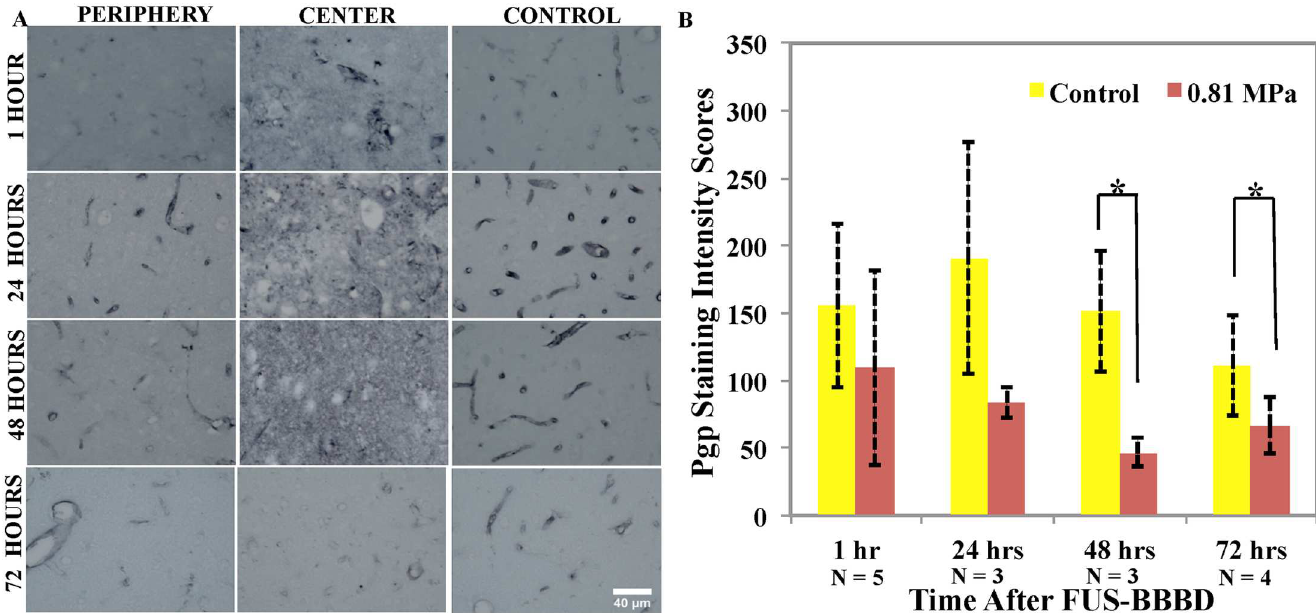
Fig 5. A. Representative microphotographs from regions in the sonicatedand control hemispheres at different time points after BBBD inducedby microbubble-enhanced sonicationat 0.81 MPa. Except at 72 hours, the center of the sonicatedregionwas diffusely stained. At the periphery,the staining intensity was reducedat all time points. Fig 5. B. Pgp stainingintensity scores at different time points after BBBD inducedby microbubble-enhanced sonicationat 0.81MPa. A comparisonof Pgp immunostaining in sonicatedand control hemispheres found statisticallysignificantdifferencesbetween animalsthat were sacrificed48, 72 hours after BBBD (p < 0.05)but not at one (p = 0.25) or 24 hours (p = 0.094). Scale bar: 40 μ